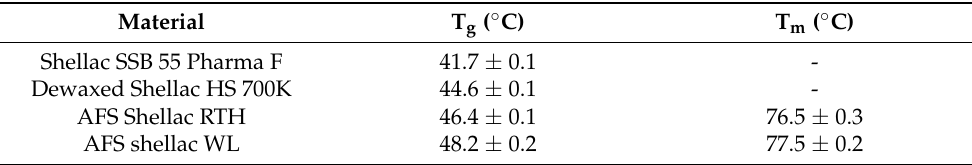
Table 4. Glass-transition temperatures and melting temperatures of different shellac grades.